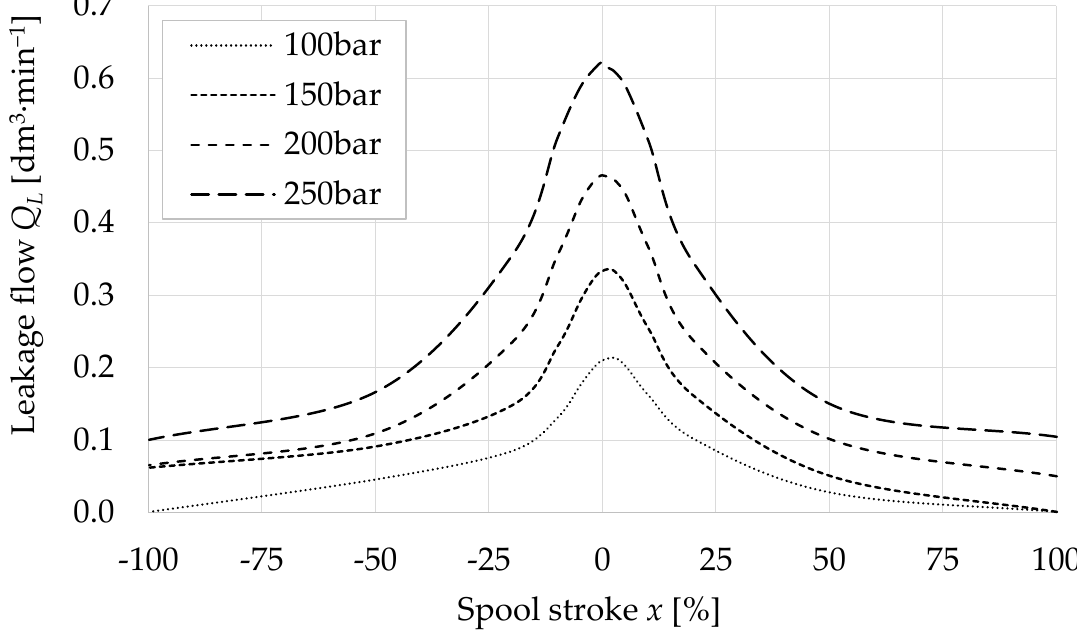
Figure 8. Leakage curves for different supply pressures.